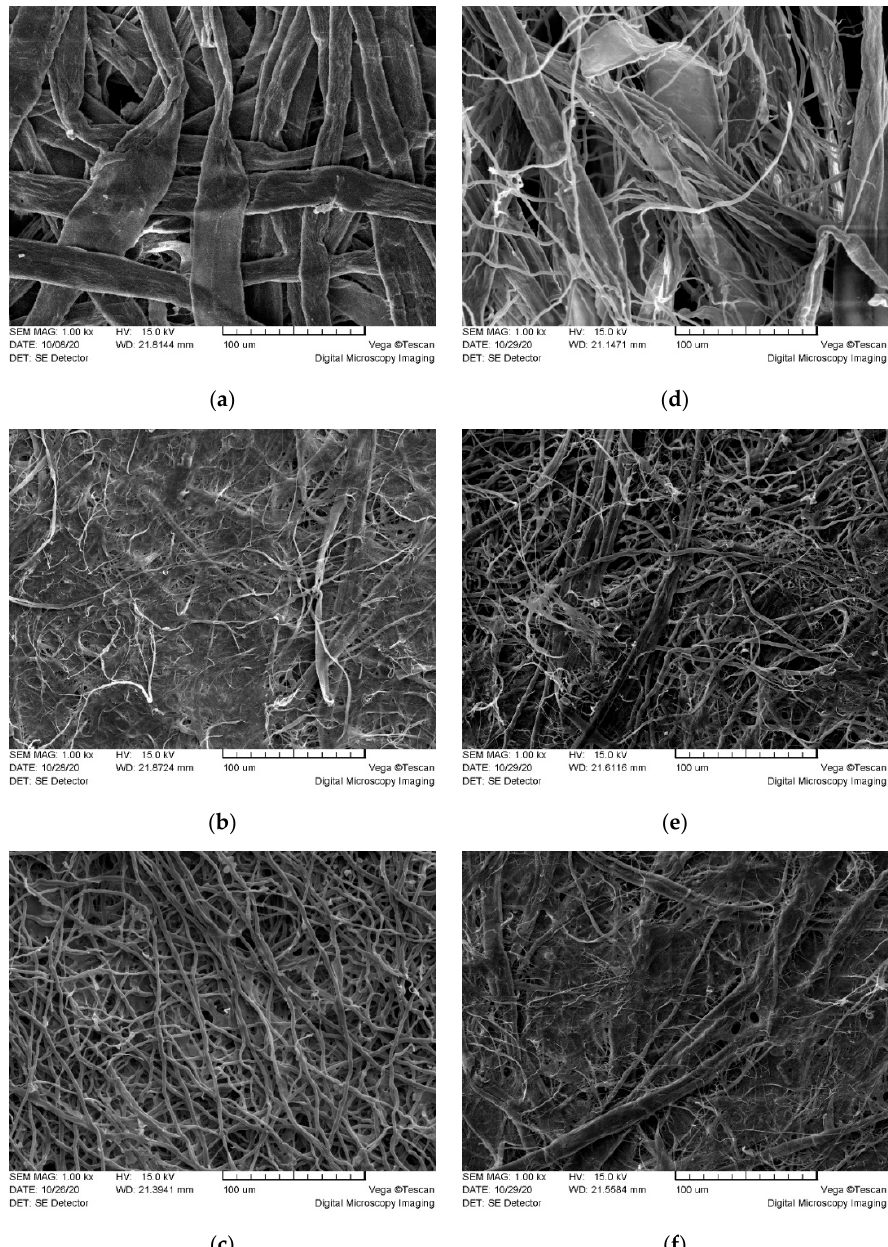
Figure 3. Ultrastructure of raw materials (left column) from ( a ) Kraft fibers (KF), ( b ) hemp fibers (HF), and ( c ) fungal fibers (FF Ga), and mycocel biopolymer compositions (right column): ( d ) KF FF (Ga); ( e ) HF FF (Ga); ( f ) KF HF FF (Ga). SEM, 1000×. Bar = 100 µm.